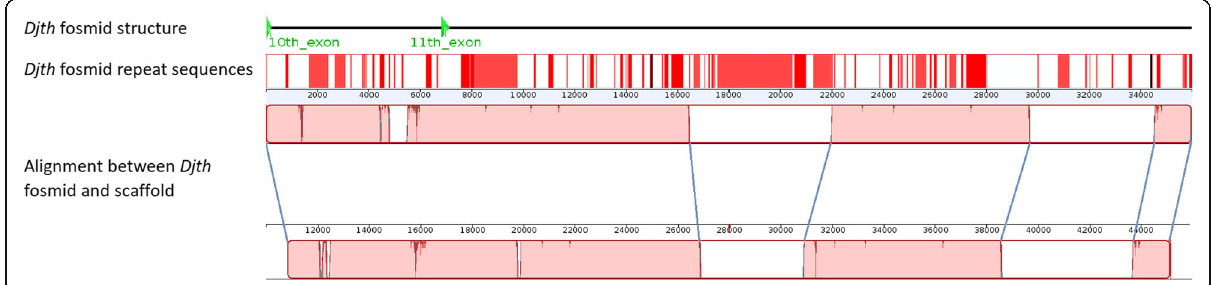
Fig. 4 Alignment between the Djth fosmid insert sequence and its corresponding genome scaffold. In the illustration of the Djth fosmid structure, green arrowheads show the 10th and 11th exons of the Djth gene in the fosmid (see Fig. 2). In the illustration of the Djth fosmid repeated sequences, red bars represent repetitive sequences. In the illustration of the alignment between Djth fosmid and scaffold, pink blocks show matched sequences between the fosmid and the corresponding scaffold, while white blocks show mismatches, which were mainly caused by gaps in the